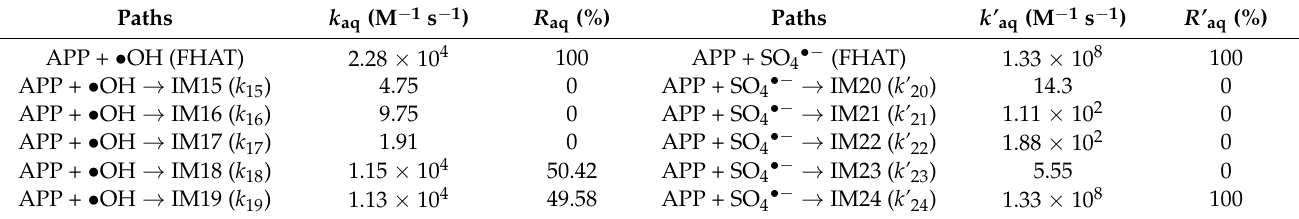
Table 4. The calculated rate constants ( k aq , k ’ aq ) and branching ratio ( R aq , R ’ aq ) for the formal hydrogen atom transfer channels in the aqueous phase at 298